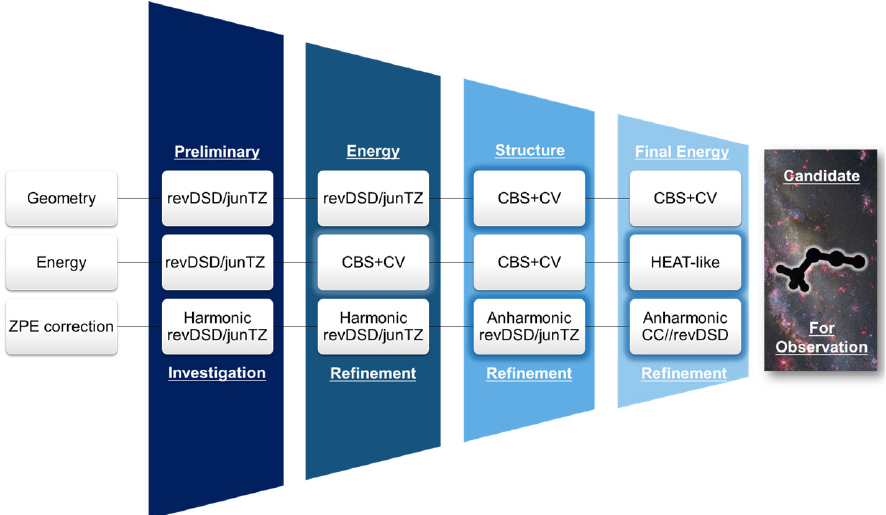
Figure 5. Schematic representation of the computational protocol developed in this work for the individuation of potential candidates for astronomical